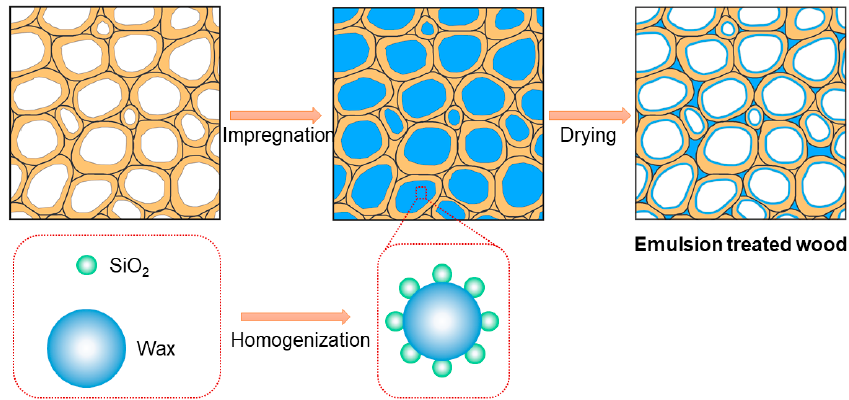
Figure 5. Illustration of the fabrication process of the emulsion treated wood. After drying, the paraffin Pickering emulsion was de-emulsified and adhered to the interior wood surfaces.